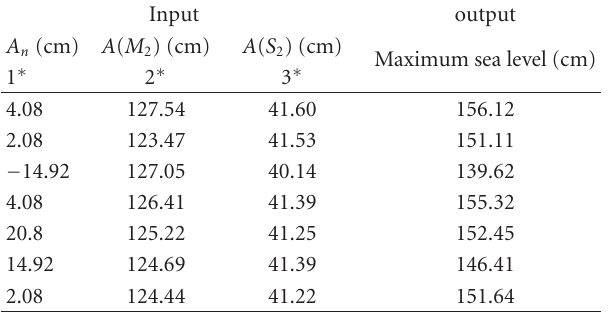
Table 5: Calculated spring tide from di ff erent